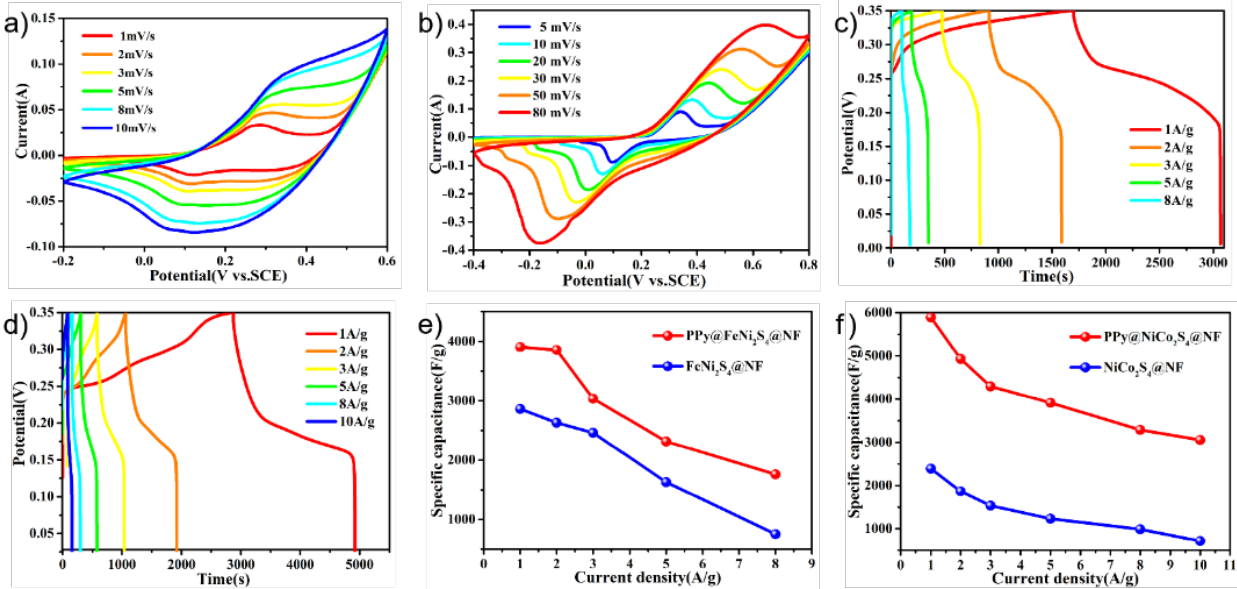
Figure 4. ( a ) CV curves of the PPy@FeNi 2 S 4 @NF electrode at various sweeping rates. ( b ) CV curves of the PPy@NiCo 2 S 4 @NF electrode at various sweeping